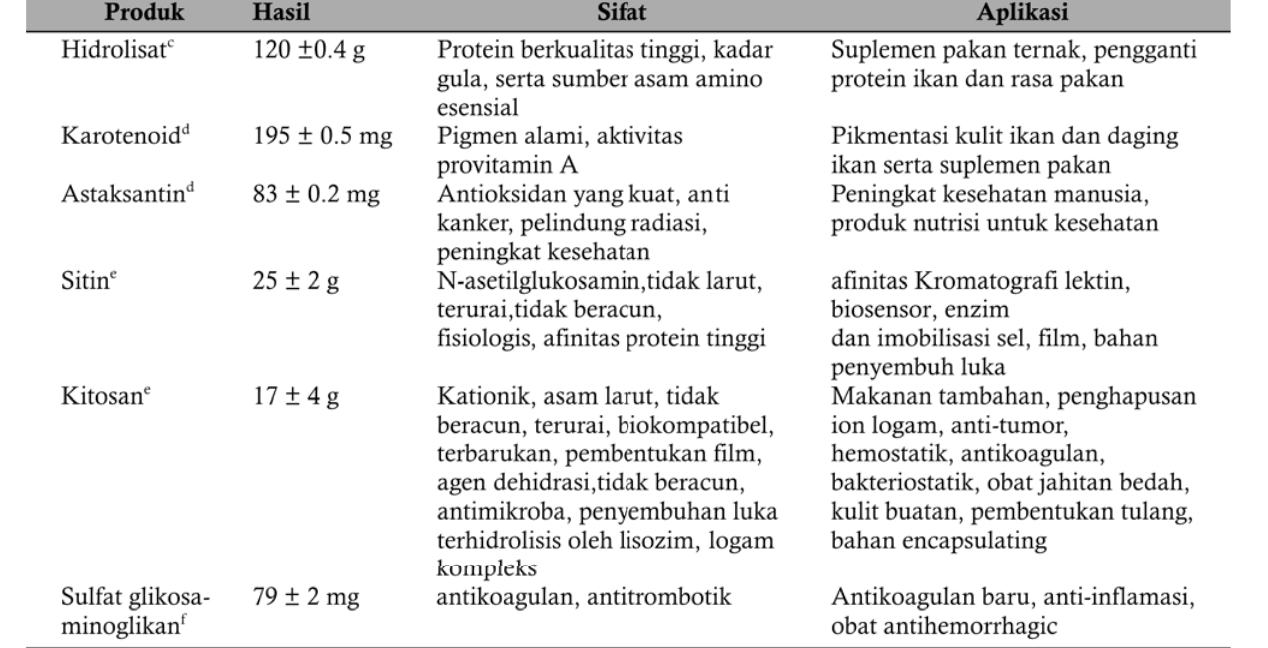
Tabel 8. sifat serta aplikasi